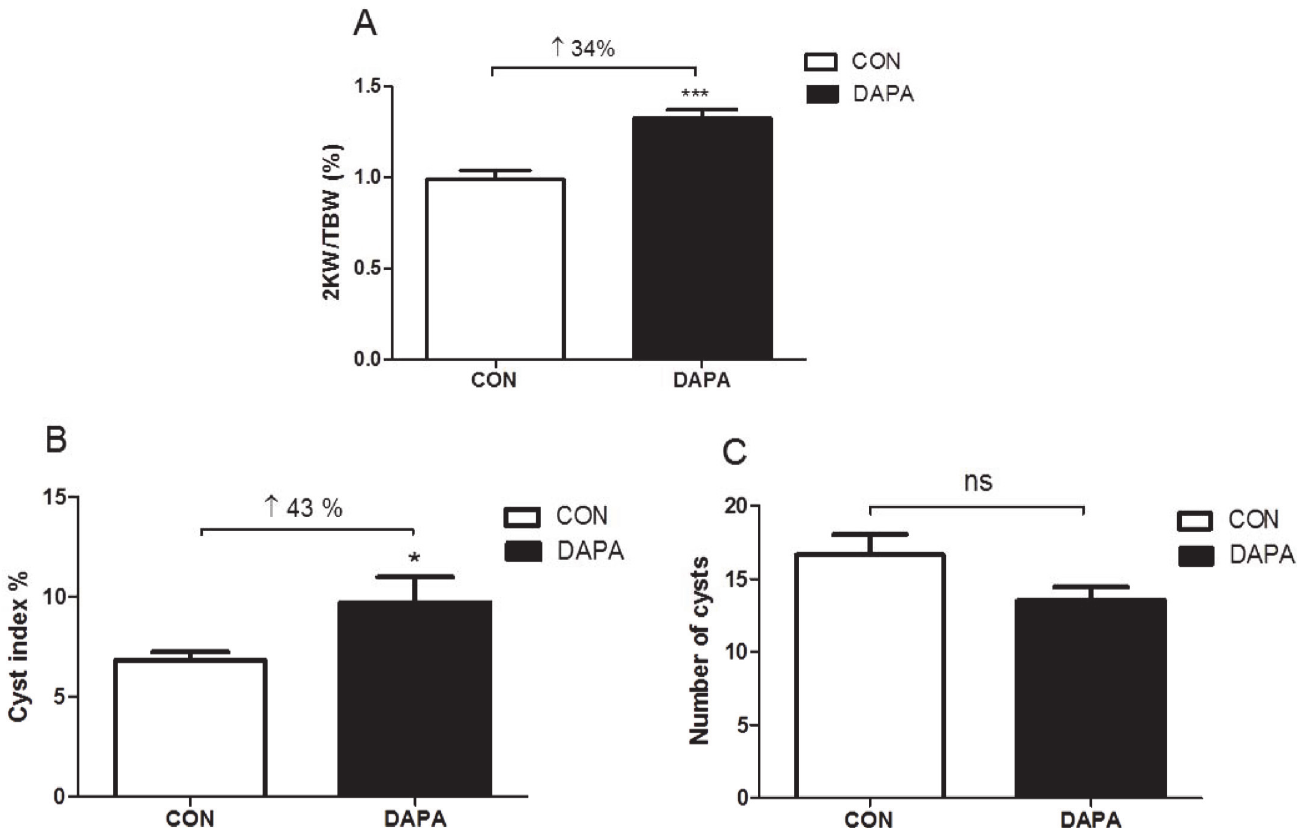
Fig 4. Effect of DAPA on kidney weight and cyst index. Ratio of two kidney weights to total body weight (2KW/TBW) (A), cyst index (B) and number of cysts (C) after 6 week treatment with vehicle (CON) or DAPA in PCK rats. N = 8 per group. Columns represent means ± SE. * P < 0.05, *** P < 0.001, ns = non-